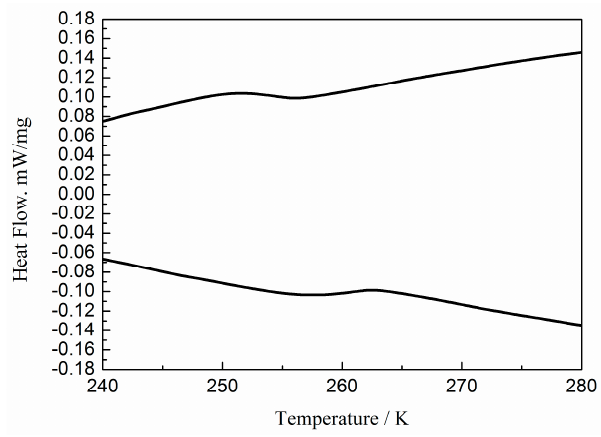
Figure 1. DSC curves for compound 1 in terms of reversible phase transitions.